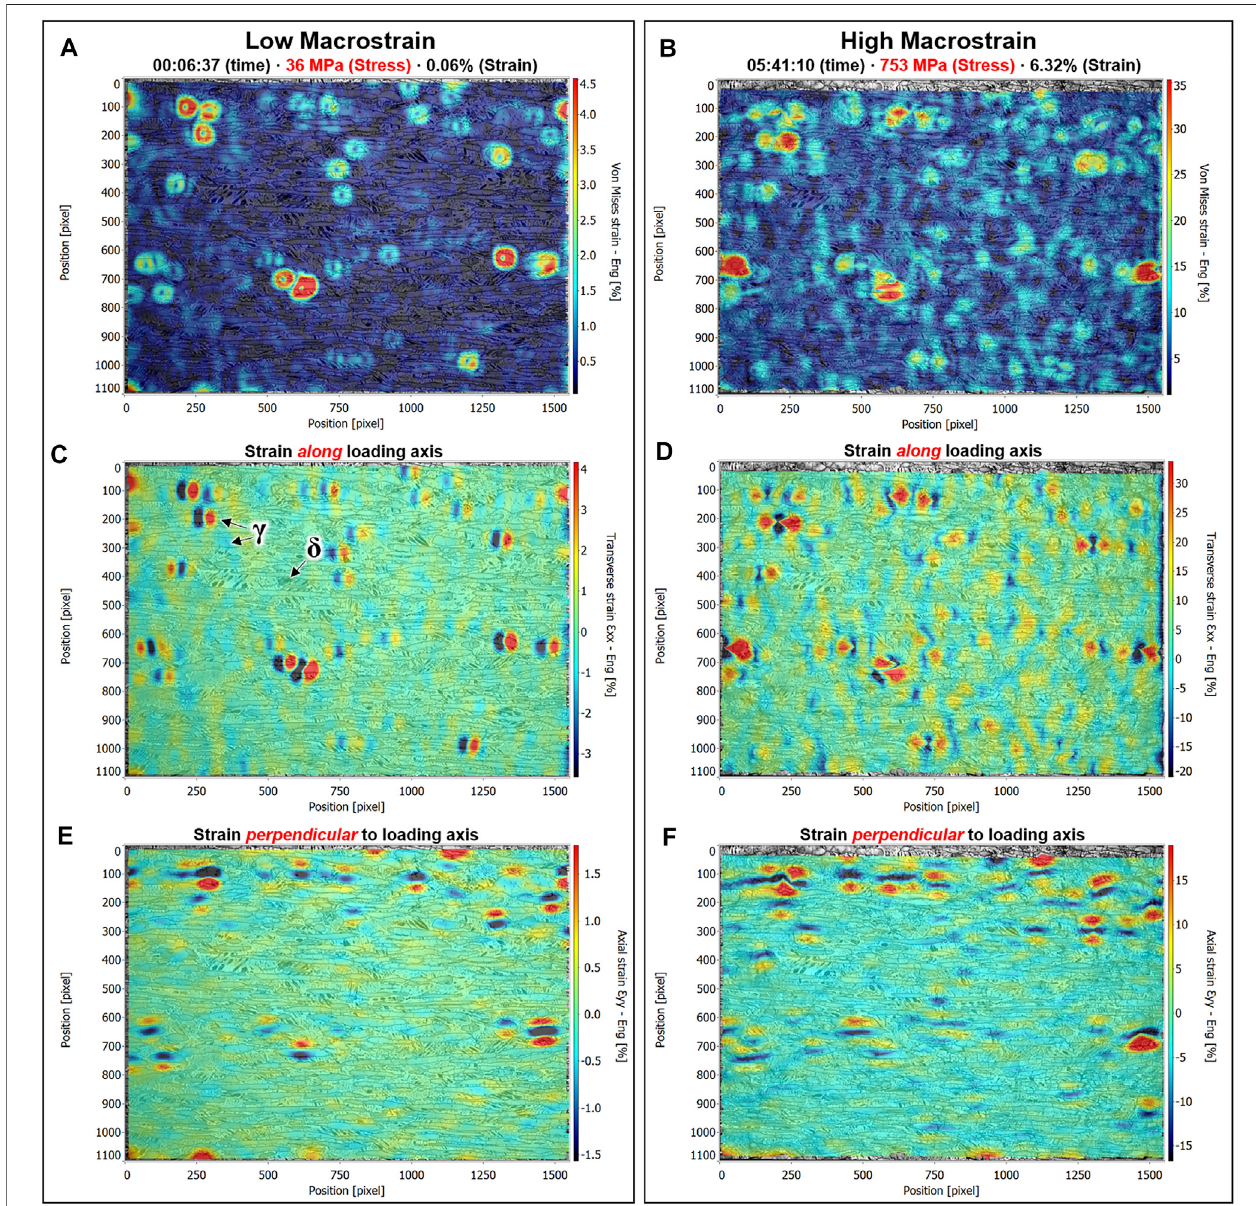
FIGURE 14 | DIC analysis results showing (A,B) the von Mises microstrain evolution, (C,D) the strain evolution along the loading axis, (E,F) the strain evolution perpendicular to the loading axis during mechanical elongation of the microstructure with hydrogen charging. The maps in (A,C,E) show strain evolution for applied low stress (36 MPa), and those in (B,D,F) show the progressed deformation after plastic deformation (753 MPa). Note the microstructure behind the strain maps showing austeniteandferritegrainsincontrast.Theloadingaxisisdirectedtothehorizontaloftheimages.Thetimeformataboveeach fi